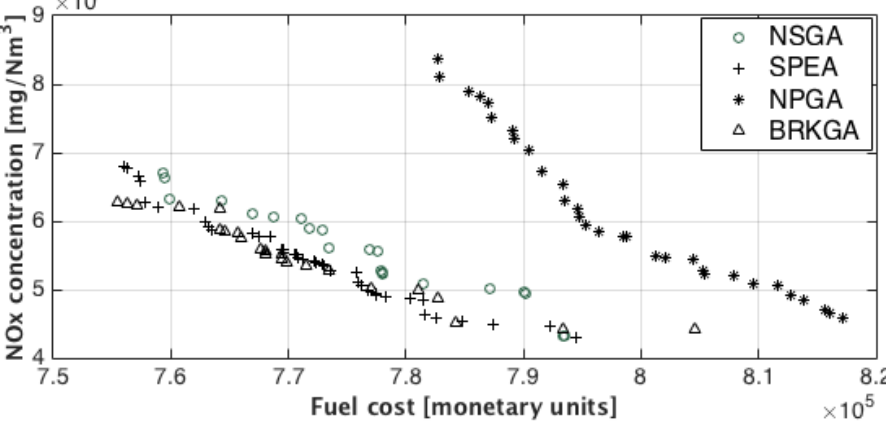
Figure 3. Pareto-optimal fronts obtained from different algorithms in a single run for 10